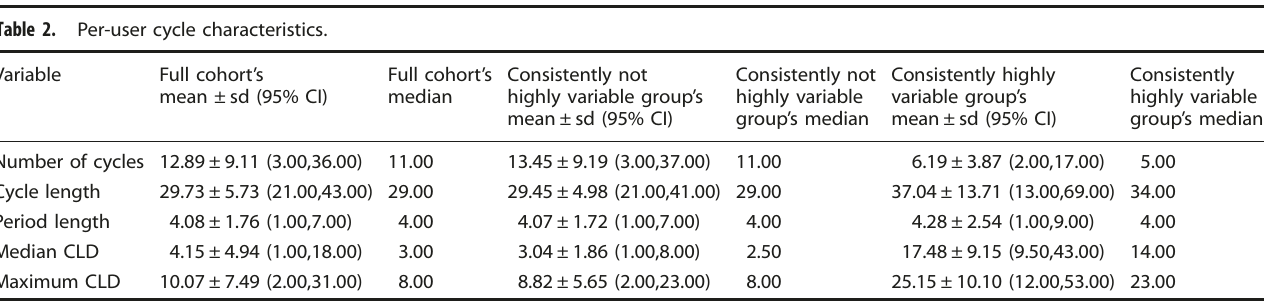
Table 2. Per-user cycle characteristics.